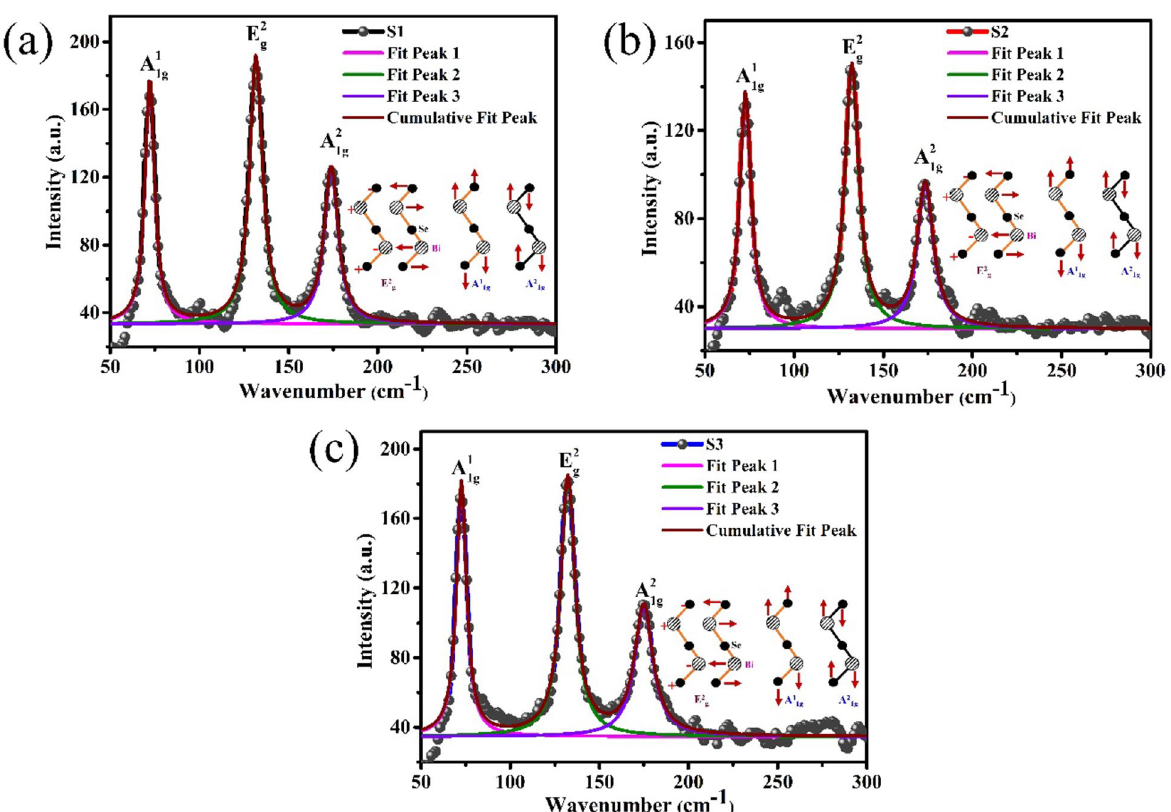
Figure 2. Raman vibrational modes of Bi 2 Se 3 thin films on sapphire (0001) for samples: ( a ) S1, ( b ) S2 and ( c ) S3.